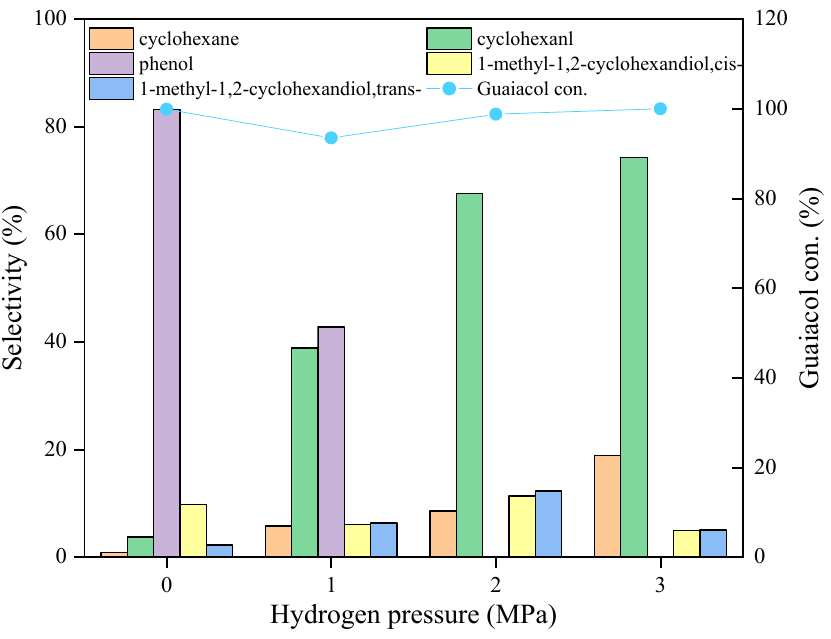
Figure 6. Guaiacol conversion and product distribution at different hydrogen pressures. Reaction conditions: Ni3Mo1@C catalyst, T = 240 °C, and t = 4 h.